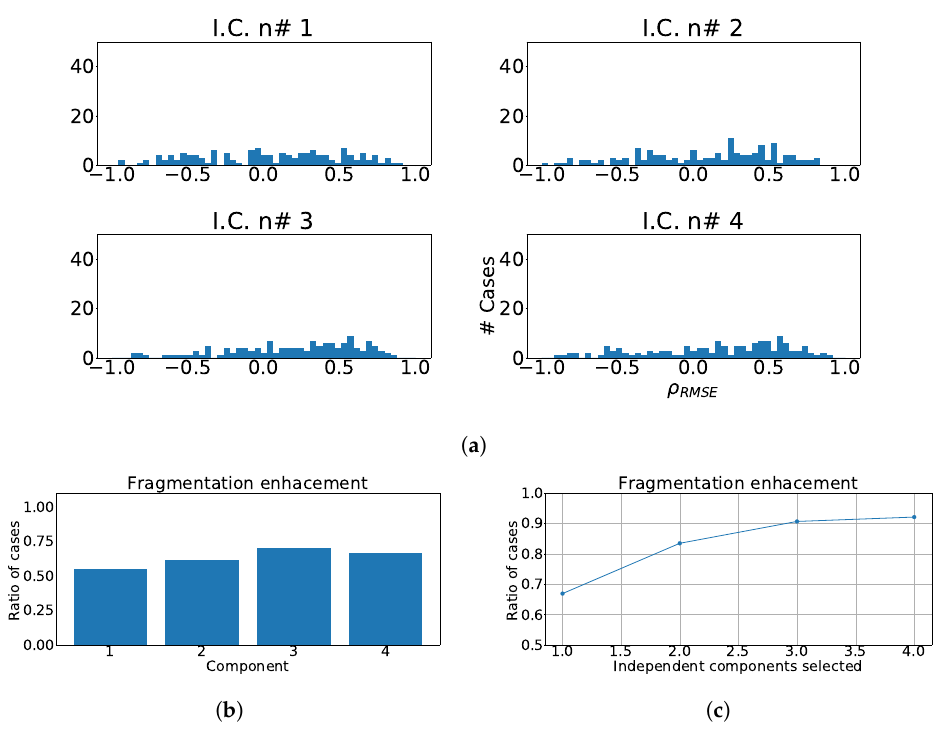
Figure 12. Different measurements for the antero-septal region of the heart with ICA model. The panel ( a ) shows the distribution of ρ RMSE coefficient for each independent component, values lower than zero represents cases where the RMSE measured over the ECG is greater than RMSE measured over the independent component. Panel ( b ) shows the ratio of fragmentation wave enhancement for each independent component, this ratio is computed as cases where the ρ RMSE value is greater than zero. Panel ( c ) shows the cumulative ratio of fragmentation wave enhancement, this ratio is computed by joining the results of isolated independent